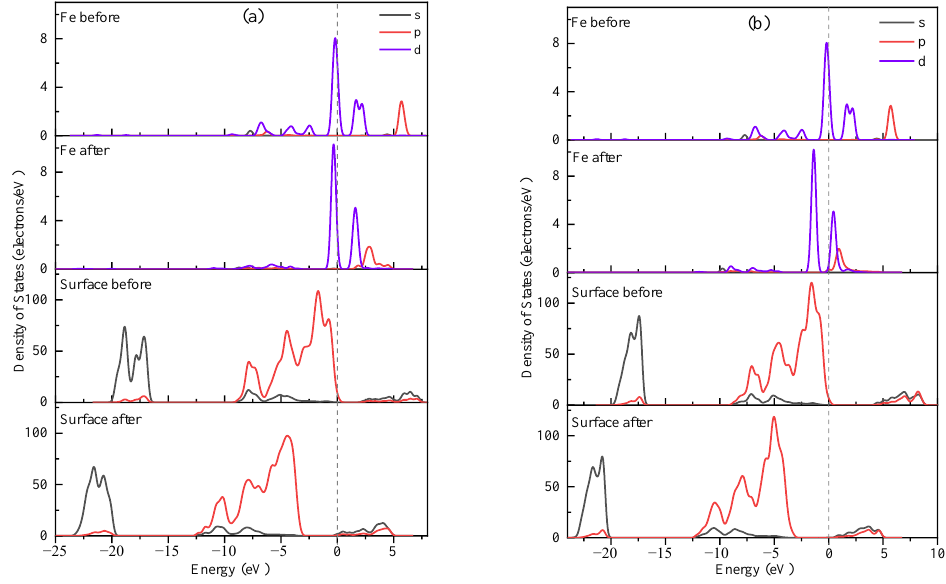
Figure 6. The PDOS of outer layer adsorption of Fe with Si-O surface ( a ) and Al-OH surface ( b ).